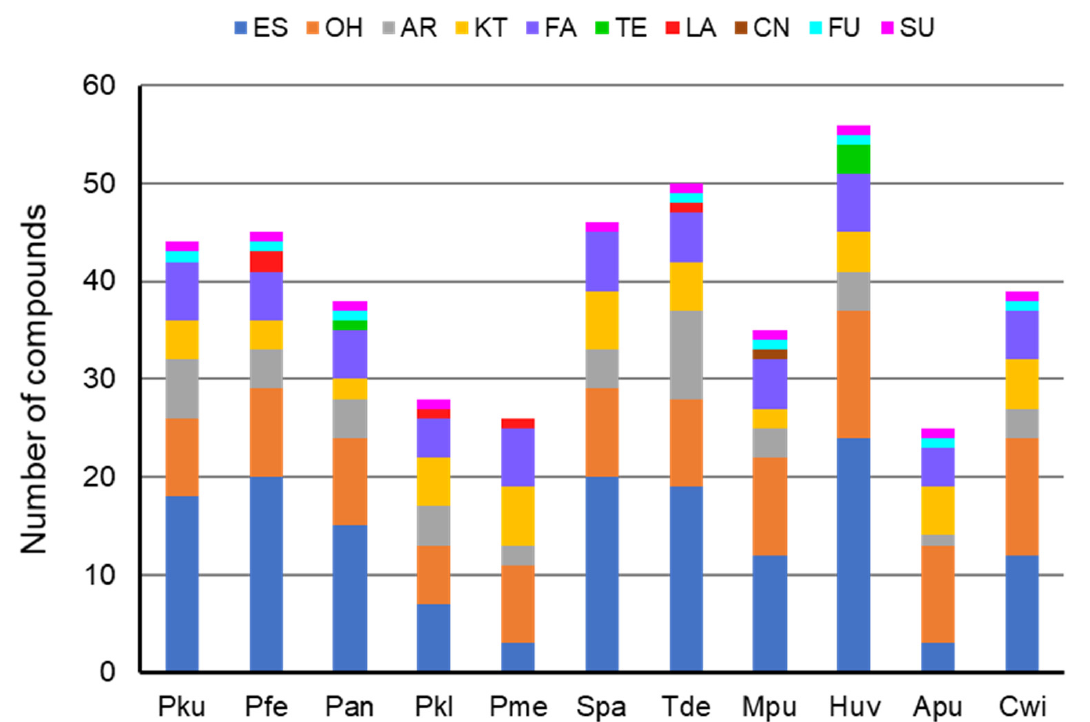
Figure 1. Chemical diversity of the volatile blends produced by yeasts. Pku– Pichia kudriavzevii , Pfe– P. fermentans , Pan- P. anomala , Pkl- P. kluyveri , Pme- P. membranifaciens , Spa- Saccharomyces paradoxus , Tde- Torulaspora delbrueckii , Mpu- Metschnikowia pulcherrima , Huv- Hanseniaspora uvarum , Apu- Aureo- basidium pullulans , Cwi- Cryptococcus wieringae . Functional group of volatiles: ES–ester; OH–alcohol; AR–aromatic; KT–ketone; FA–fatty acid; TE–terpenoid; LA–lactone; CN–isothiocyanoate; FU—fu- rane; SU–sulphide.